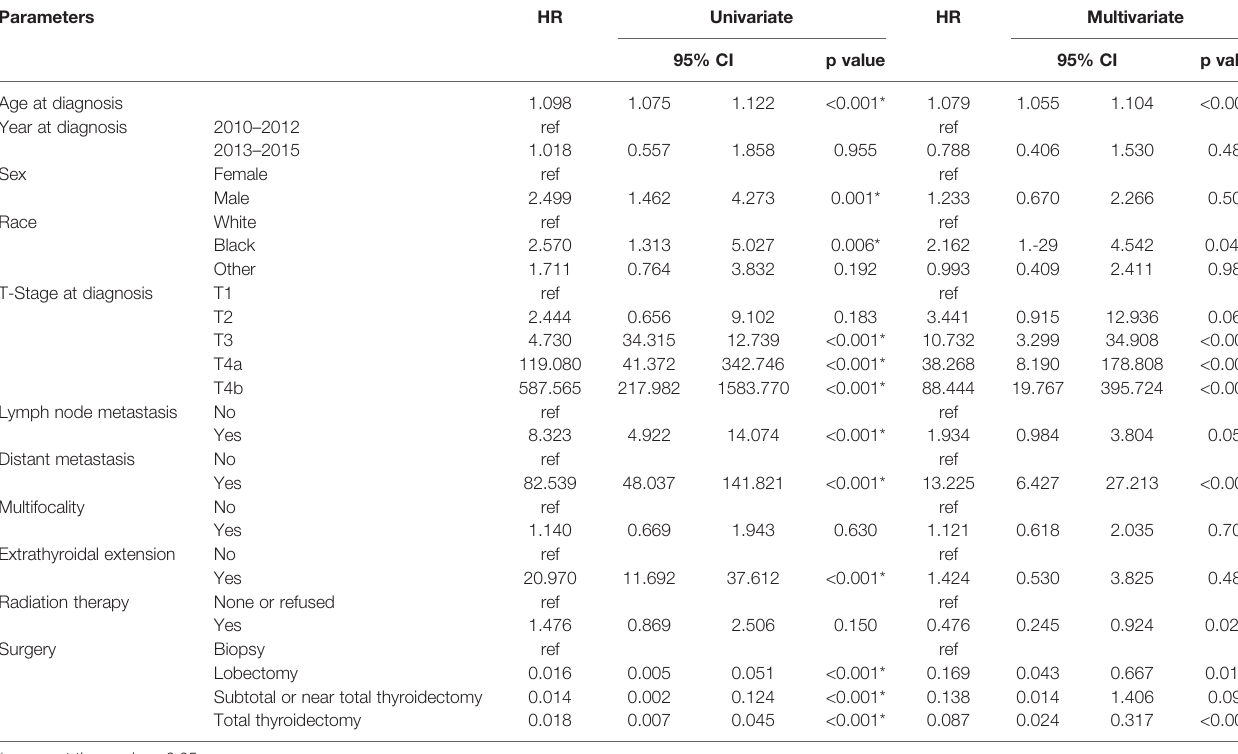
*represent the p value